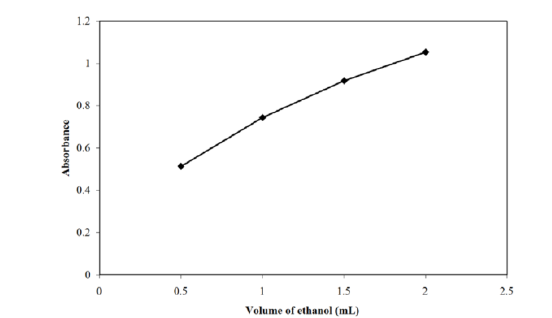
Figure 3. Effect of the volume of ethanol (disperser solvent) on the absorbance of AS-MB ion-pairs obtained from DLLME. Extraction conditions, as with Fig. 1 ; concentration of MB, 5.0×10 -5 mol L -1